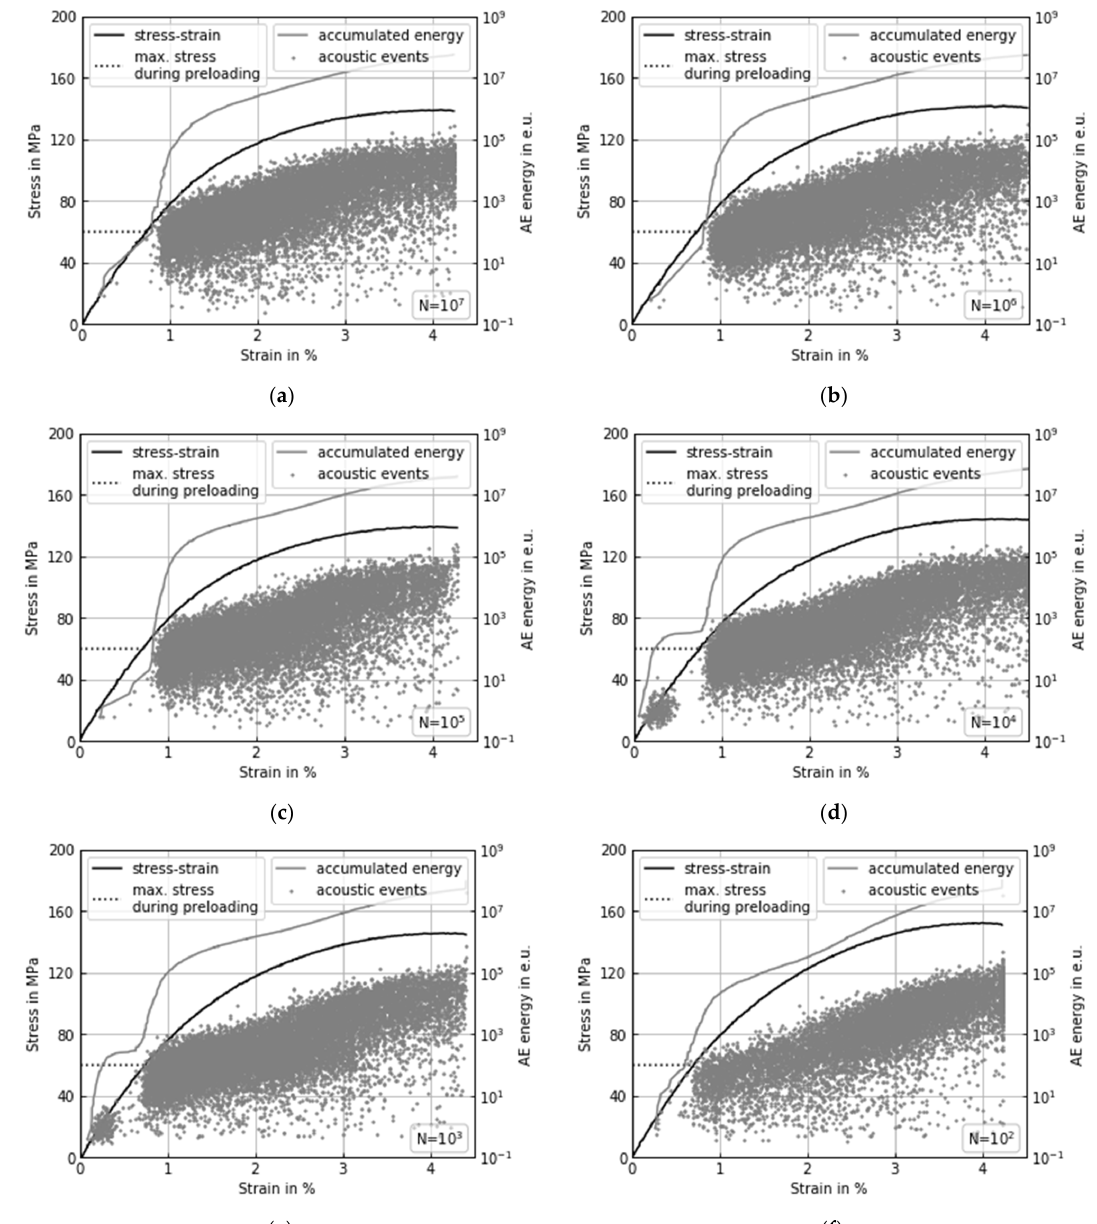
Figure 7. Stress–strain curve, acoustic energy and accumulated acoustic energy in energy units (1 e.u. ≙ 1×10 −21 J) of preloaded specimens with σ max = 59.9 MPa: ( a ) 10 7 ; ( b ) 10 6 ; ( c ) 10 5 ; ( d ) 10 4 ; ( e ) 10 3 ; ( f ) 10 2 cycles.